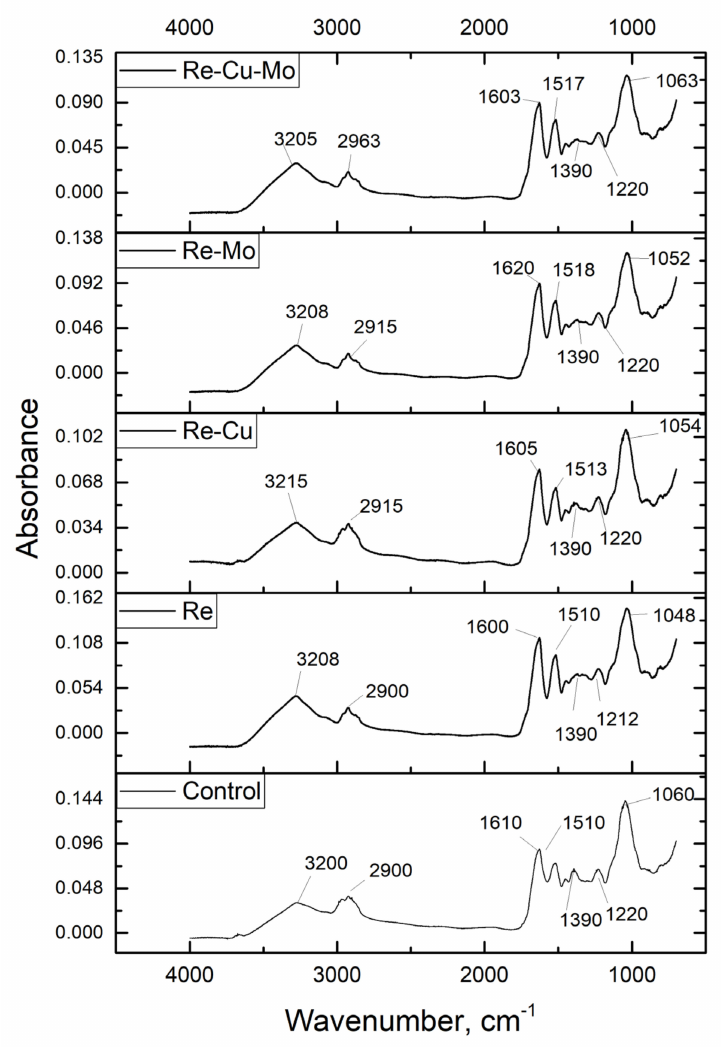
Figure 9. FTIR spectra of control and metal-loaded yeast biomass. In the Re-Cu system, in addition to ОН , C Н =C Н and N Н 2 groups, which play impor- tant roles in rhenium removal, a shift of the band of alkyl groups by 15 cm − 1 took place. As was shown in isotherms studies, an increase in rhenium concentration in solution did not affect significantly the removal of copper ions, which can be explained by the preference of rhenium and copper for different functional groups. Hydroxyl and carbonyl groups play important role in copper ions removal by yeast biomass [20]. The shift of the bands of the same groups was observed in the Re-Mo system. Rhenium and molybdenum have similar chemical properties, so it can be suggested that they bind to the same groups on the biosorbent surface. However, it should be mentioned that in performed experiments, rhenium removal efficiency was not affected by the presence of molybdenum ions in so- lution. According to Shan et al. [36], molybdenum ions have a high affinity to the alkyl group on the N-atom of the amine group and steric hindrance to the amine group. In the Re-Cu-Mo system, amine, hydroxyl and alkyl groups participated in removal. The decrease in molybdenum removal in equilibrium experiments can be explained by its competition with copper ions for the same binding